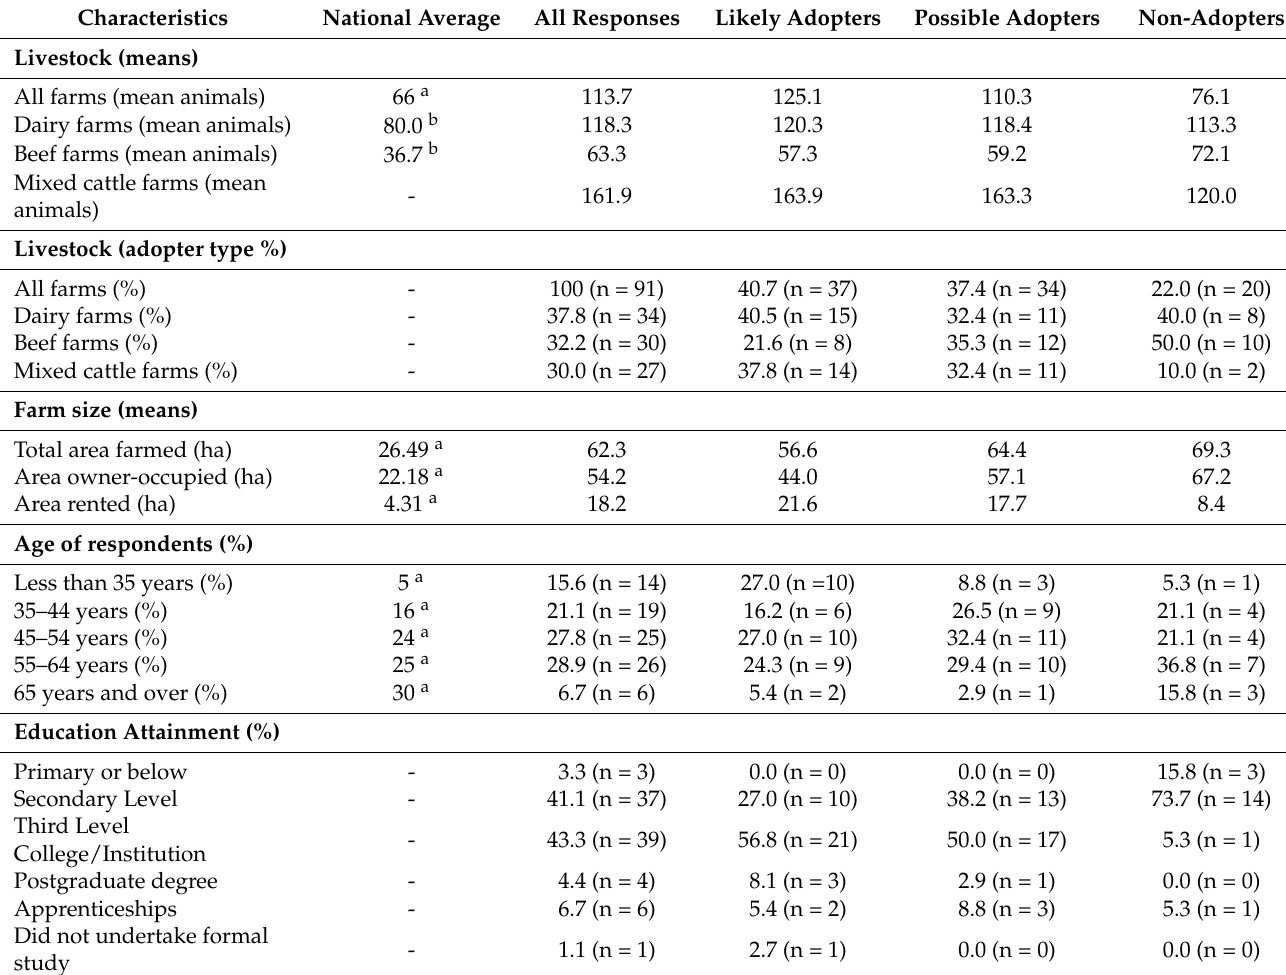
Table 1. Differences in characteristics between Likely Adopters, Possible Adopters, and Non-Adopters.